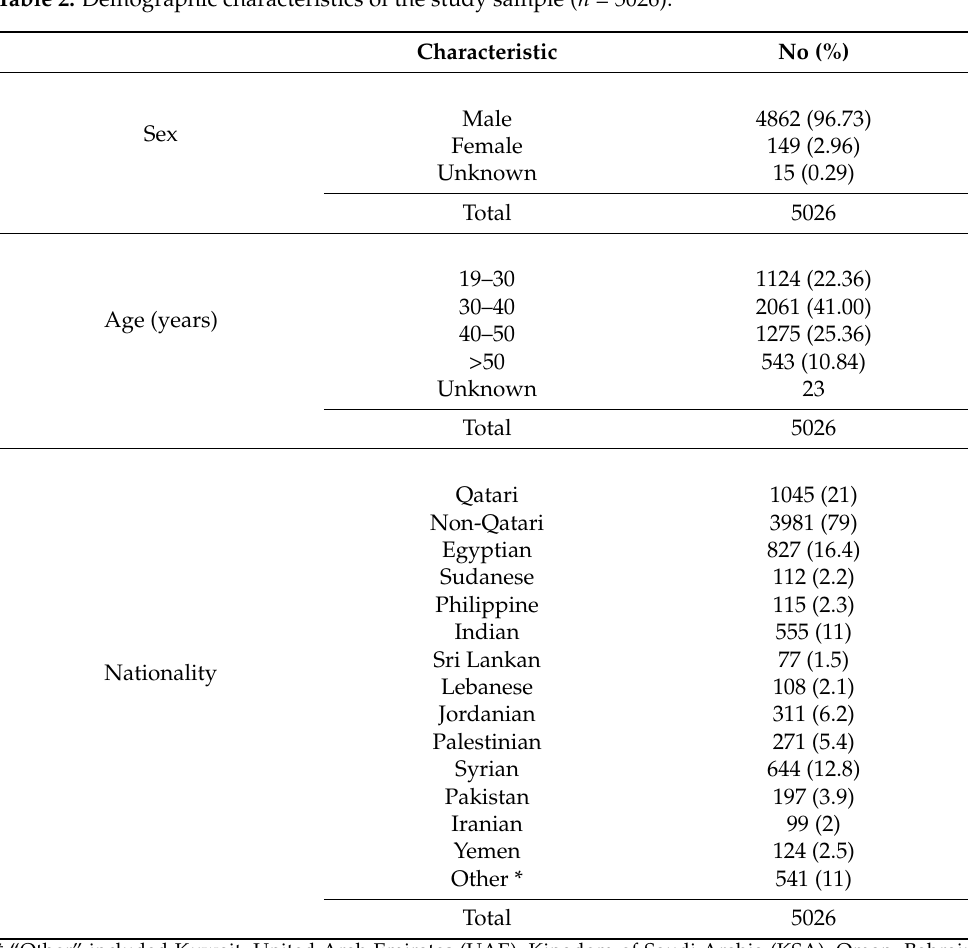
Table 2. Demographic characteristics of the study sample ( n =